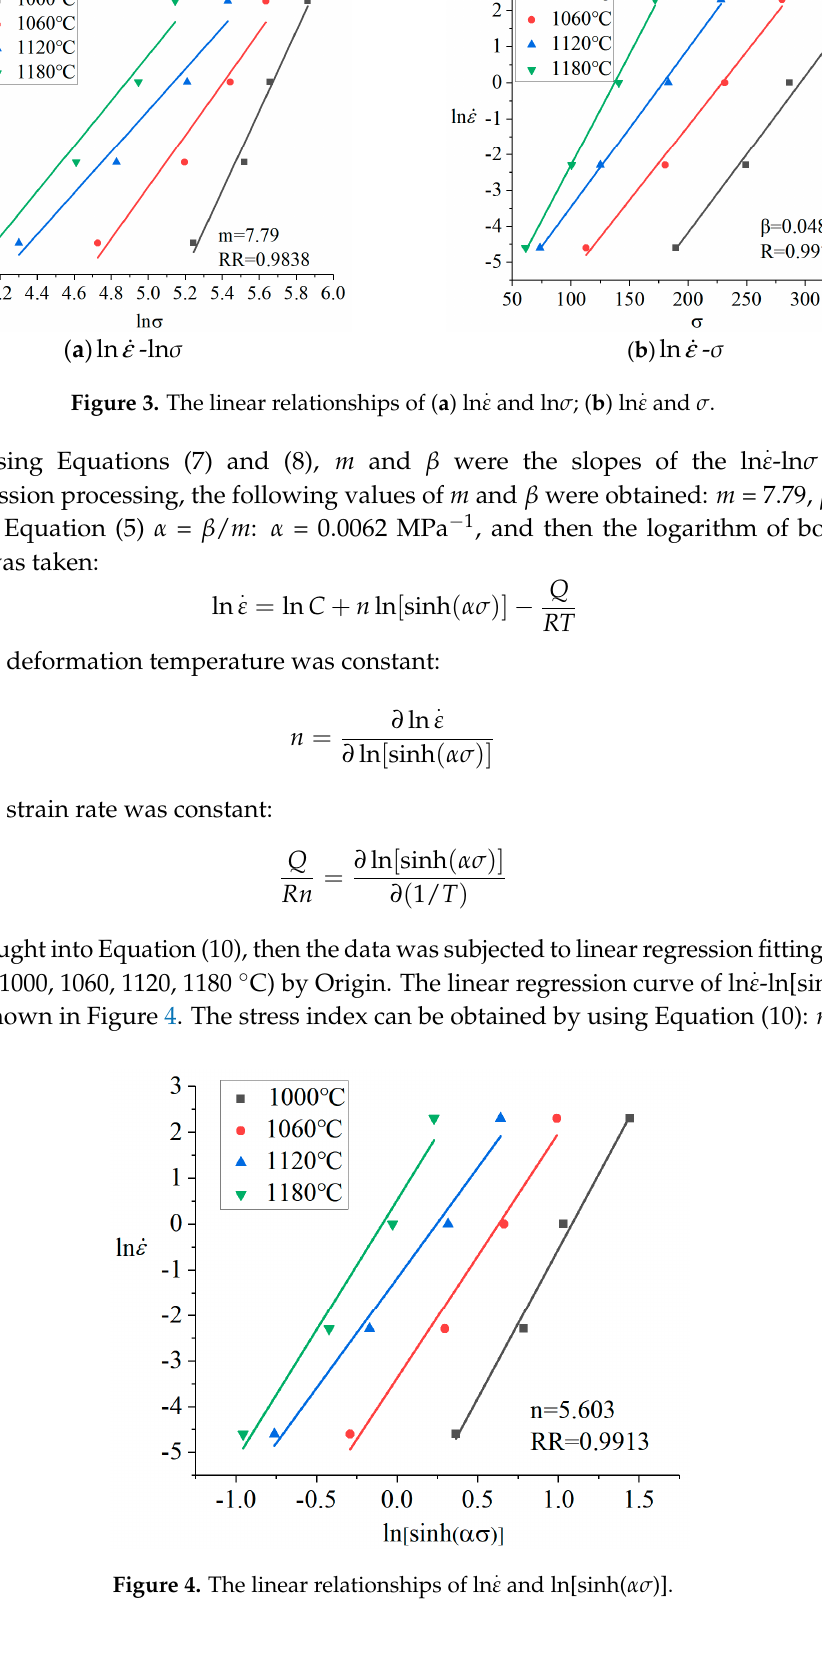
Figure 4. The linear relationships of ln  ε and ln[sinh( ασ )].